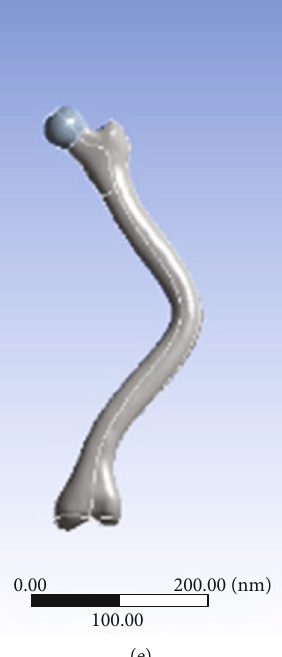
Figure 2: Examples of OI-a ff ected bone models with (a) 10 ° , (b) 15 ° , (c) 20 ° , (d) 25 ° , and (e) 30 ° bowing